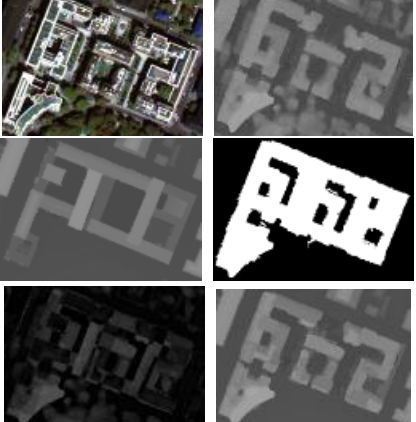
Figure 9.Top: Worldview-2 DSM (right), RGB image (left), Middle: the sum of two DSMs (right), Lidar DSM (left), Bottom: updated DSM (right), the absolute difference between two DSMs (left)